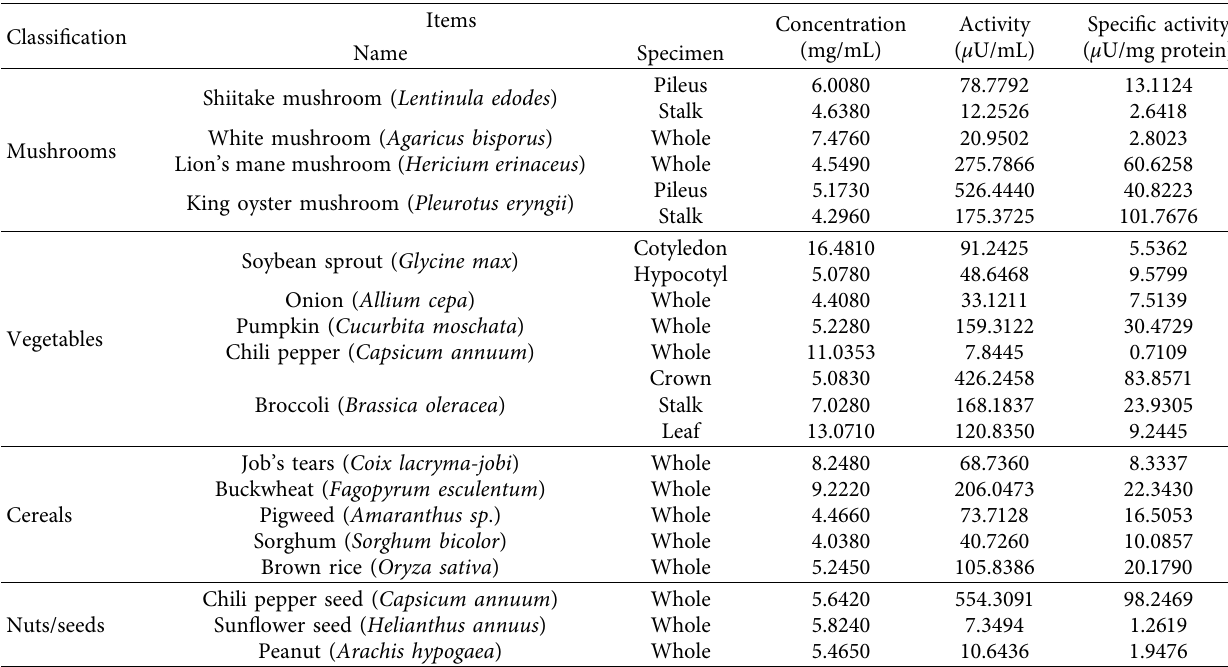
Table 2: Lipase activity in crude protein extracts from domestic agricultural products (fluorometric